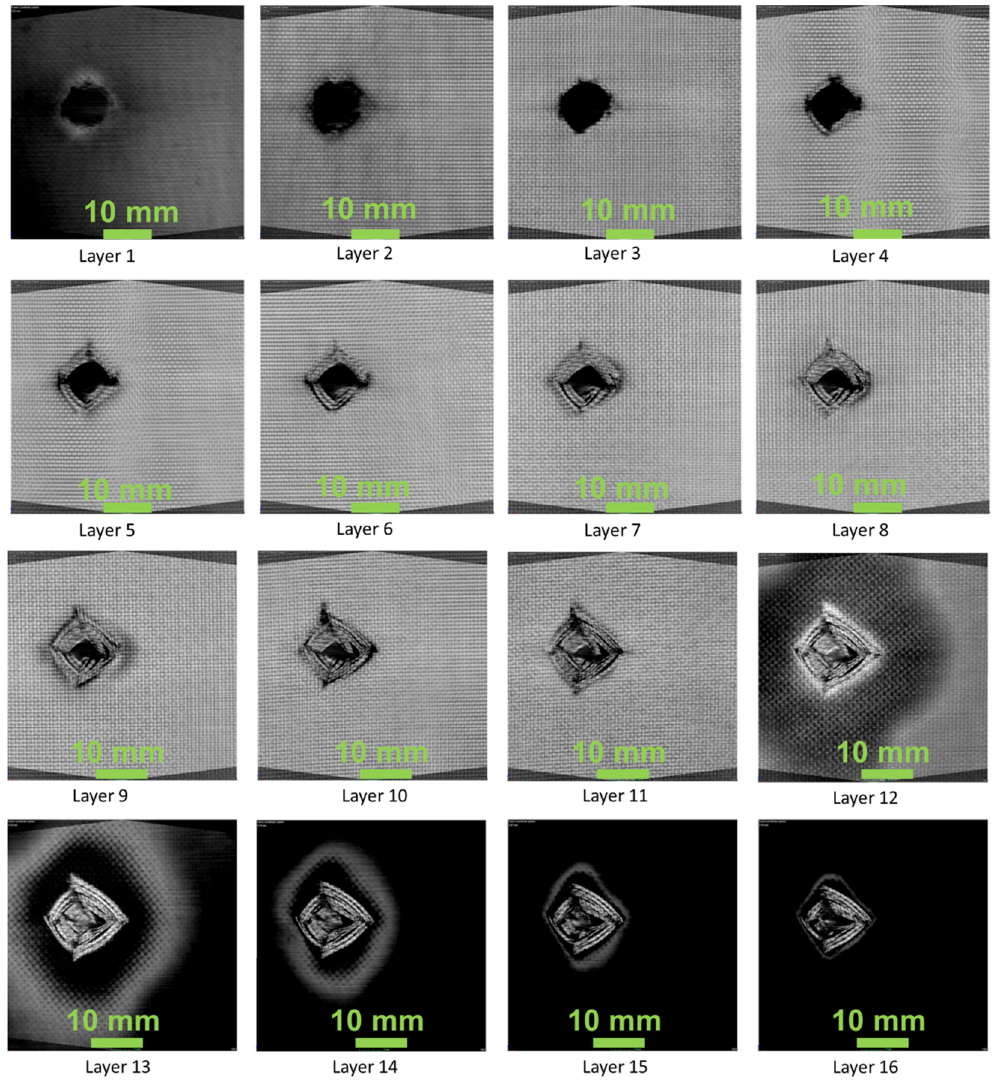
Figure 9. 60 1k /0 14E /60 1k —composite laminate failure on each layer.